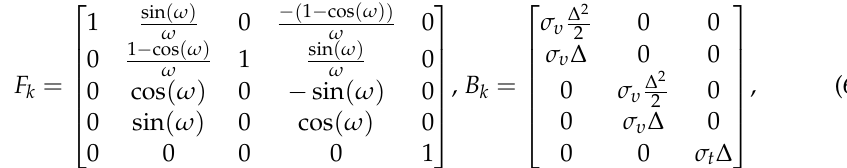
Formatted: Font: Palatino Linotype, Not Italic